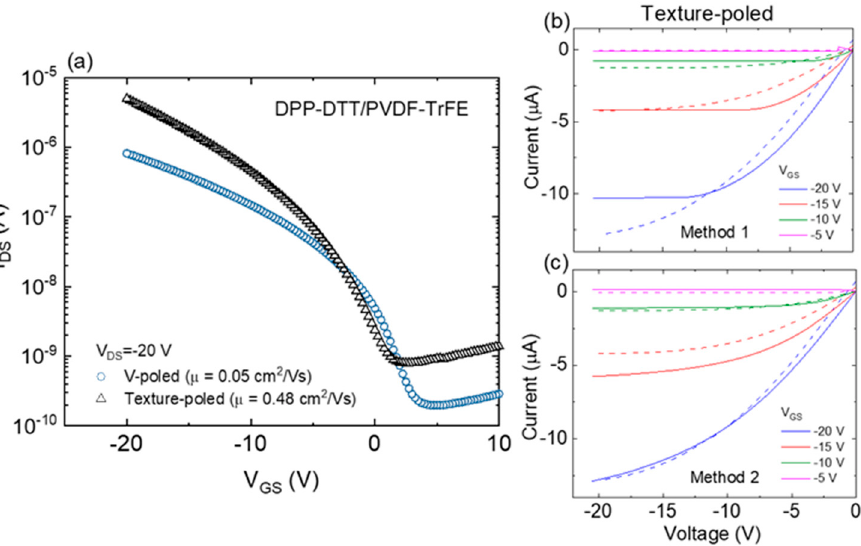
Figure 2. ( a ) Transfer characteristics from two DPP-DTT/PVDF-TrFE FETs, one where the PVDF-TrFE layer was V-poled, and in the other, texture-poled. ( b , c ) The output characteristics of the texture-poled DPP-DTT FET. The dotted lines show the experimental data. The bold lines are from the FET models, denoted as Methods 1 and 2, respectively, and discussed in the text.